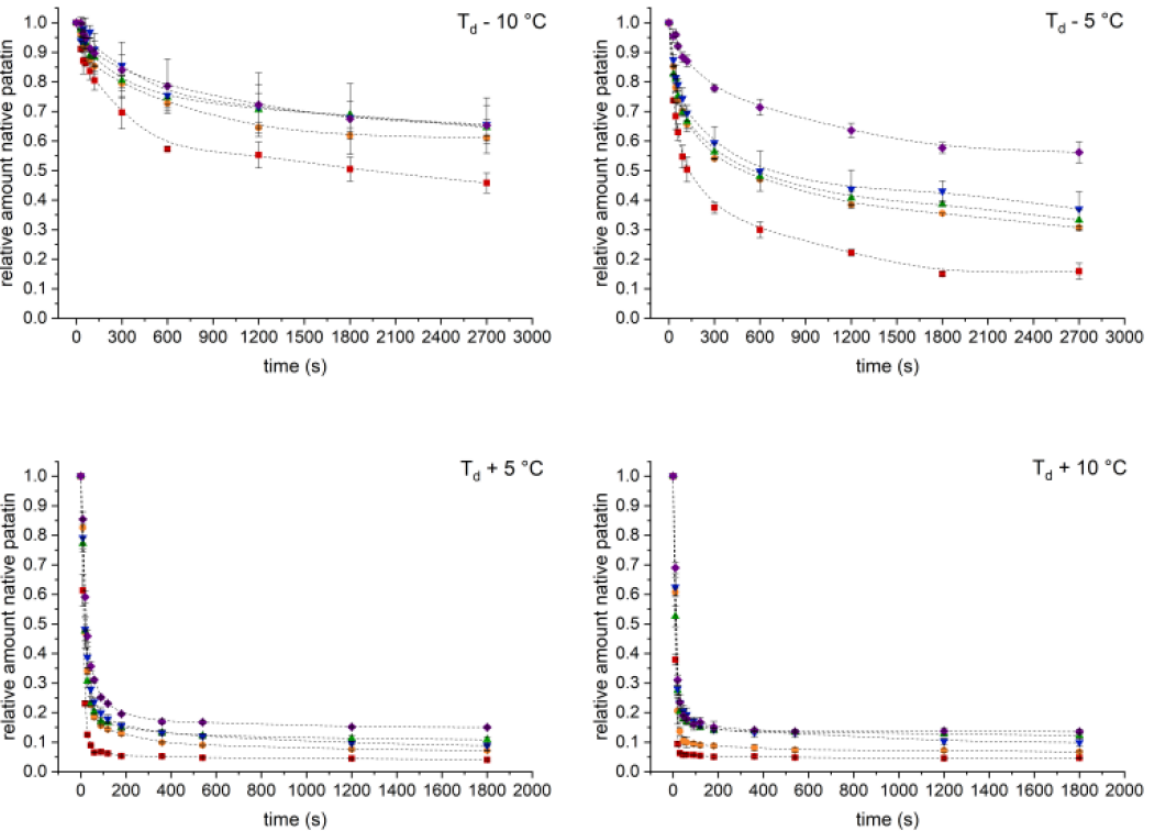
Figure 2. Decrease of native sized patatin in relation to the unheated sample during heating, determined by SEC.